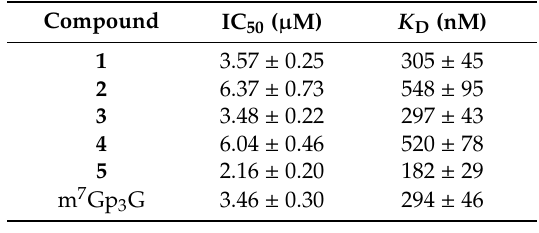
Table 1. IC 50 and K D values determined at 30 ◦ C for the binding a ffi nity for murine eIF4E. The IC 50 values were determined from the data shown in Figure 2. The K D values were calculated from the IC 50 values using a previously reported equation [33].